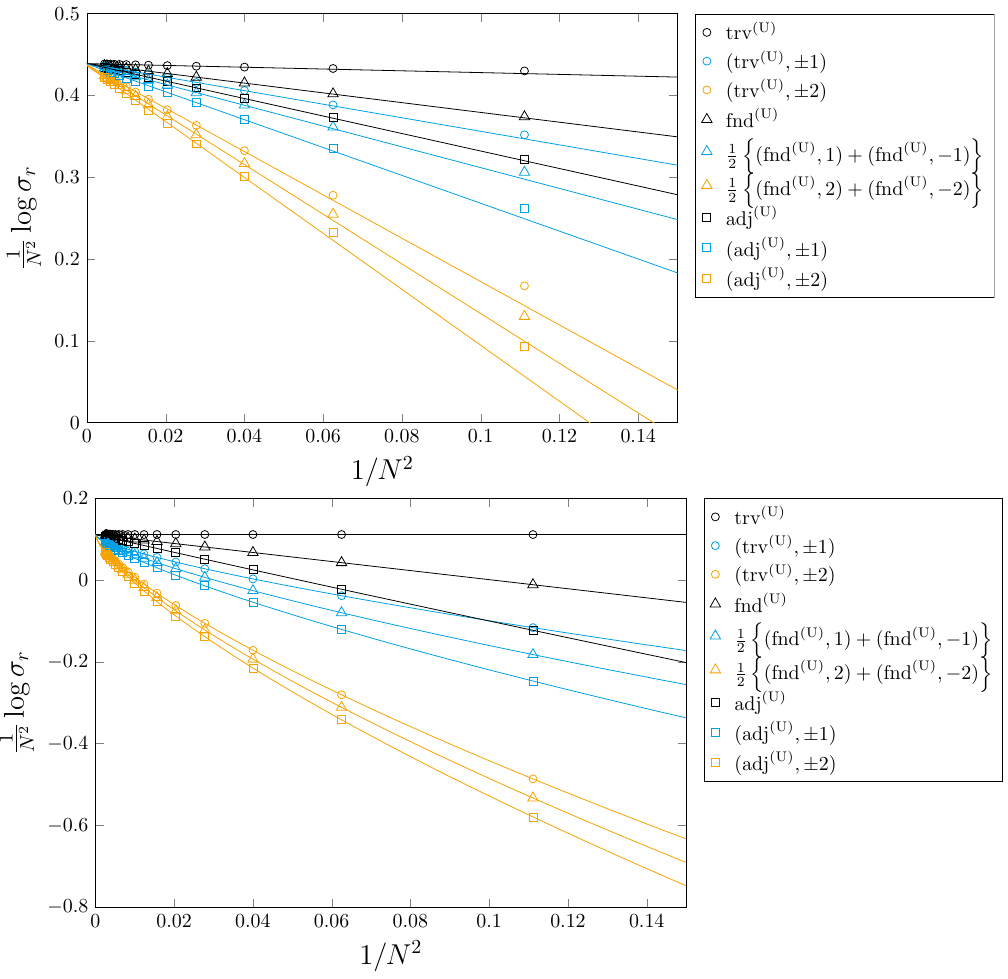
Figure 10 . (Top) The singular values 1 log σ r for the trivial (black circles), fundamental (black N 2 triangles) and adjoint (black squares) representations of U ( N ) are plotted against 1 /N 2 for the U ( N ) gauge theory with λ = 1 . 5 . We also add some charge to these representations and plot the corresponding singular values in the same figure with different colors. The lines represent fits of the results for each representation with N ≥ 7 to C + c/N 2 for λ = 1 . 5 . (Bottom) A similar plot for λ = 3 . The lines represent fits of the results for each representation with N ≥ 3 to C + a/N + bχ N /N 2 + c/N 2 . The fits for the sequence of representations without charge yield a = b = 0 within fitting